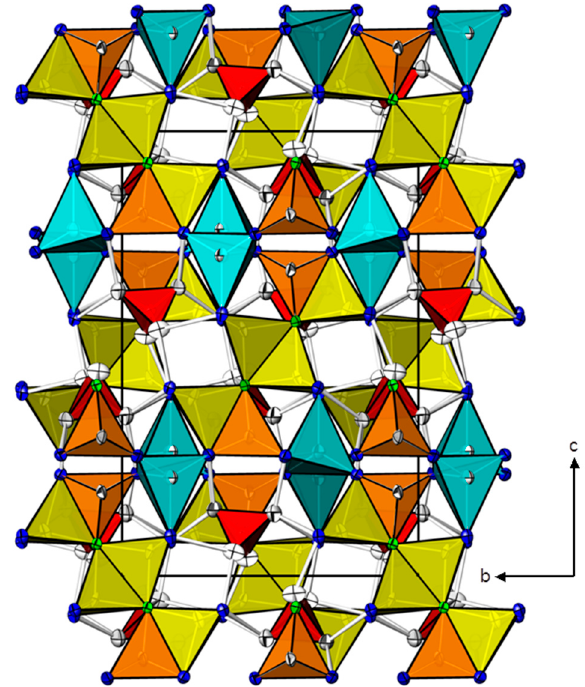
Figure 7. Crystal structure of Cd(Hg II ) 4 O 4 (CrO 4 ) using oxygen-centred tetrahedra for visualisation. [OHg 2 Cd 2 ] and [OHg 3 Cd] tetrahedra are yellow, [OHg 2 Cd] trigonal pyramids are orange and [OHg 4 ] tetrahedra are turquoise. Displacement ellipsoids are as in Figure 3.